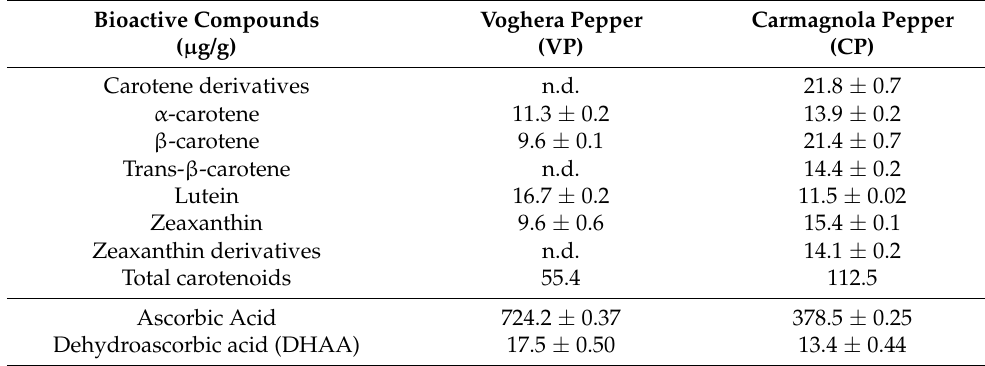
Table 1. Total carotenoids and ascorbic acid contents in the tested